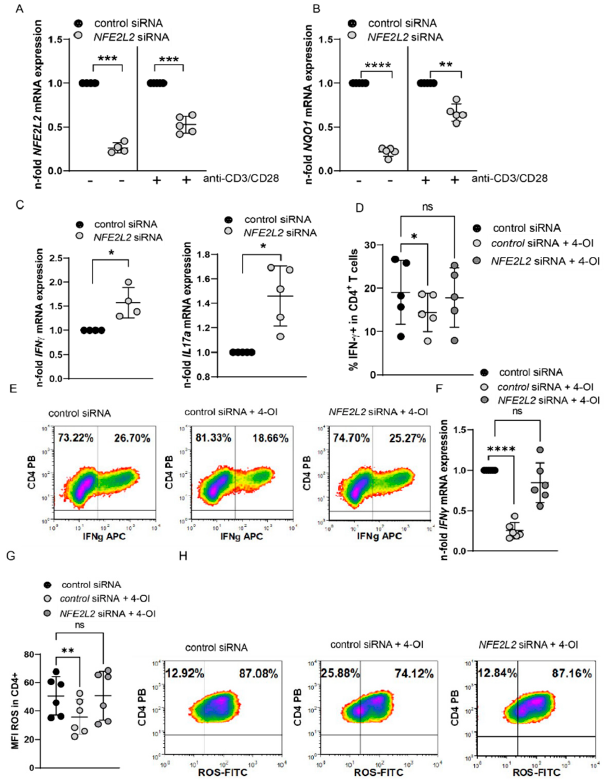
Figure 6 . 4-OI regulates T cells by NRF2. ( A – D ) PBMCs were transfected with NFE2L2 siRNA (10 nM) and control siRNA using Neon transfection system. After incubation for 24 h, cells were left